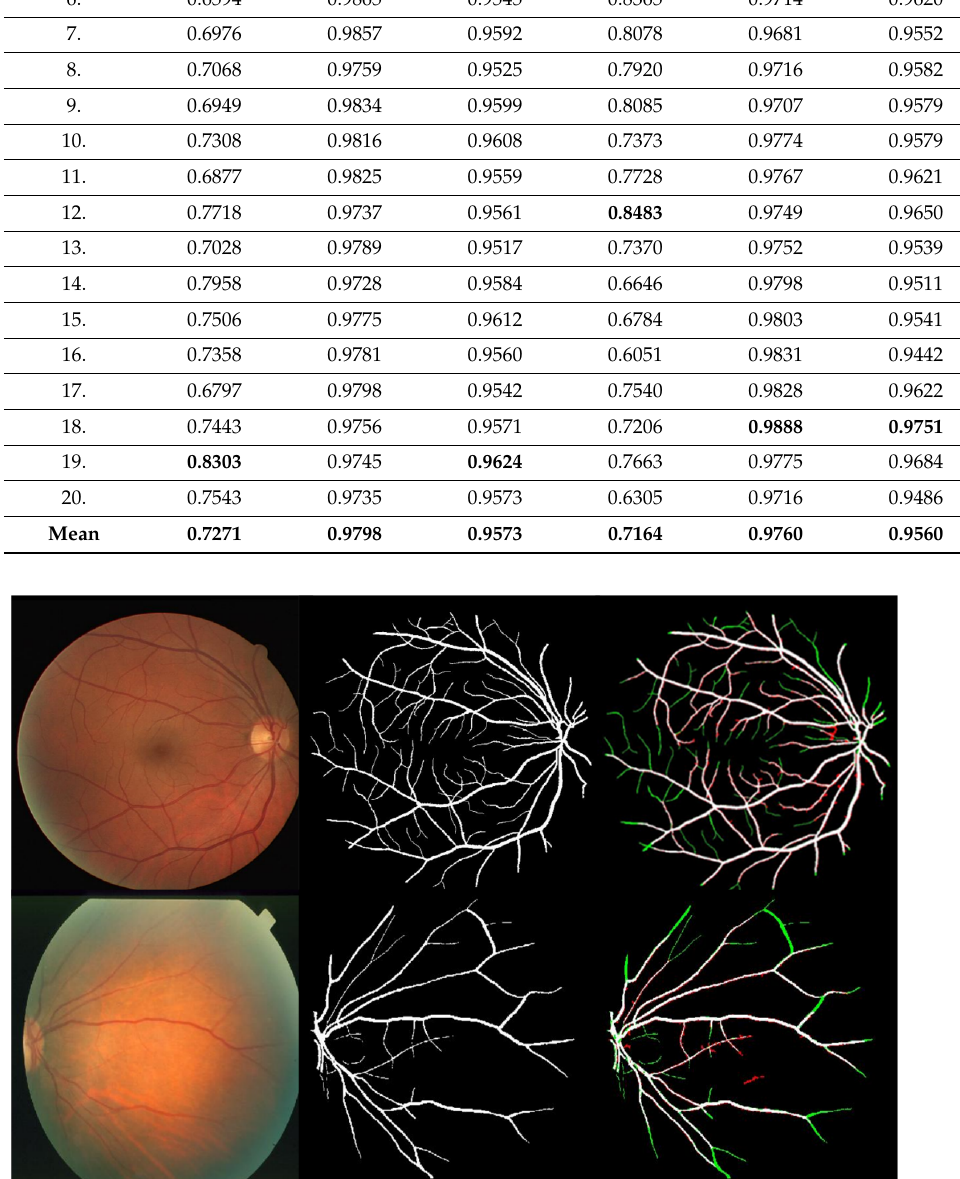
Figure 2. Best case accuracy: First column represents color images, second ground truth and third segmented images. First row contains DRIVE images, and STARE images are there in the second row. Last column: white indicate the pixels of true positives; while the green pixels denote the missed vessel pixels, whereas red are false